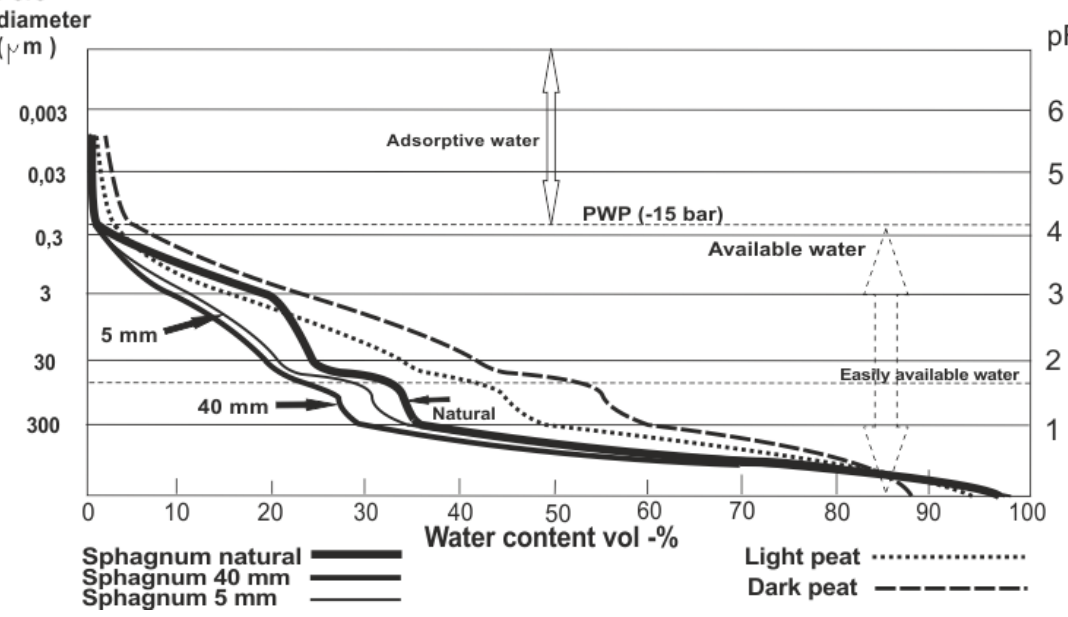
Figure 4. Volumetric water retention curves for Sphagnum moss, light peat and dark peat. Sphagnum moss was examined at fibre lengths of 5 and 40 mm and with a natural